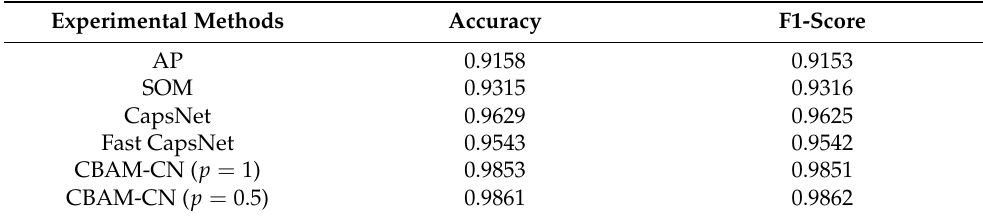
Table 3. Classification results of feature images in the training set.